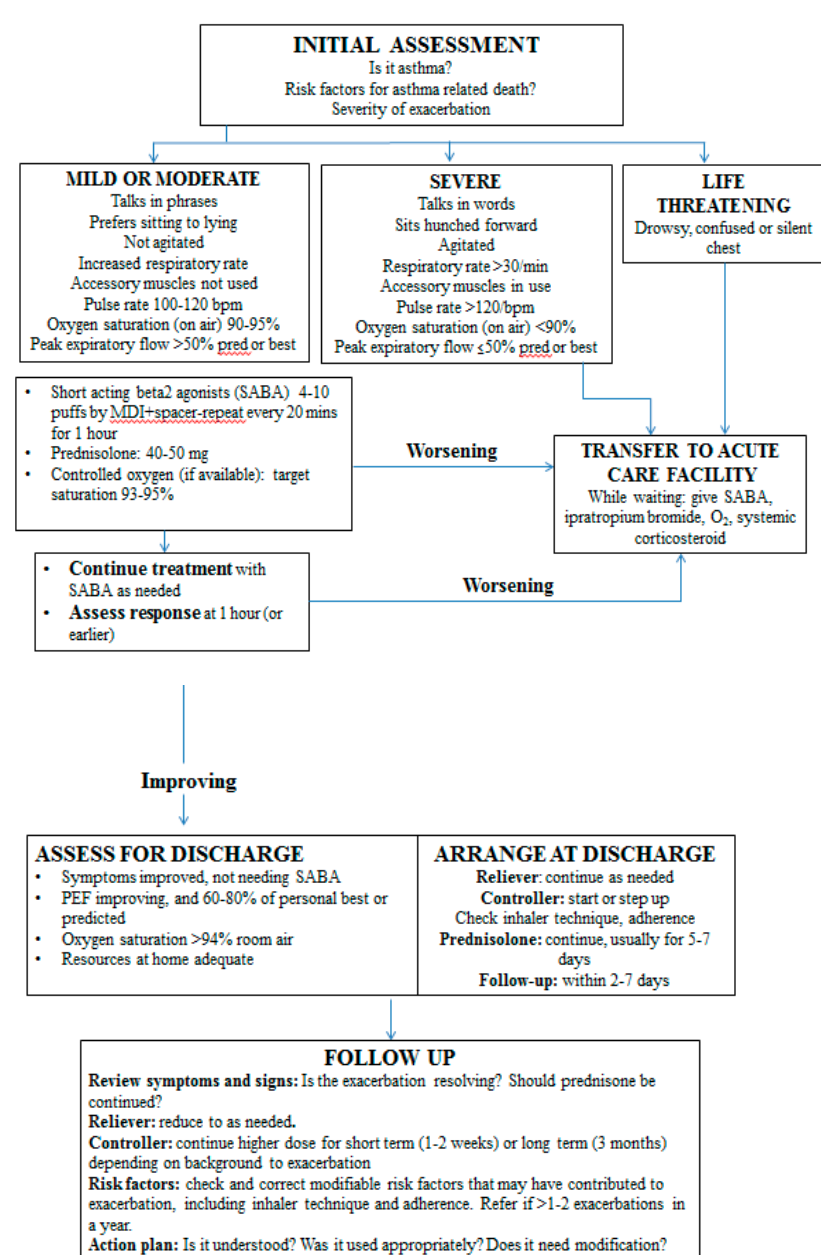
Figure 7. Global Initiative for Asthma (GINA) recommendations for the management of asthma exacerbations in acute care facility. PEF: Peak expiratory flow; FEV 1 : Forced expiratory volume in one second; SABA, short acting beta 2 agonists; ICU, Intensive Care Unit.